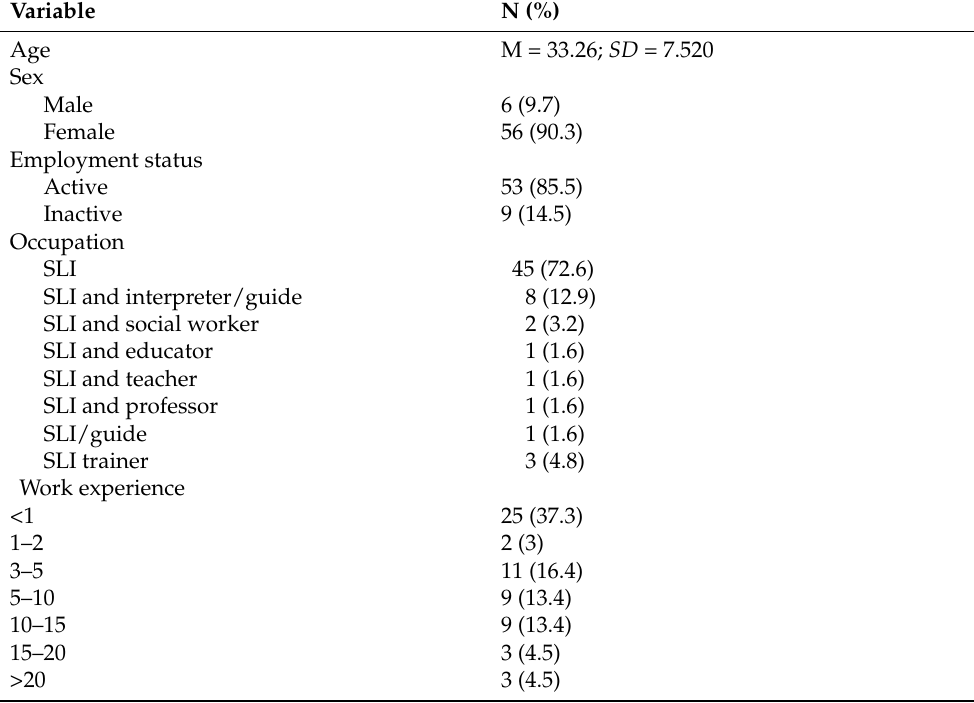
Table 1. Sociodemographic profile of sign language interpreters (SLI) and interpreters/guides and musculoskeletal disorders ( n =